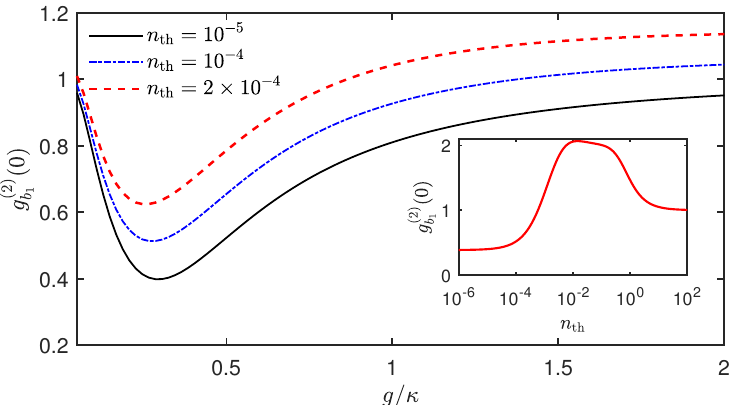
( 2 ) ( 0 ) of the SAW mode b 1 b 1 th . The figure is plotted in the